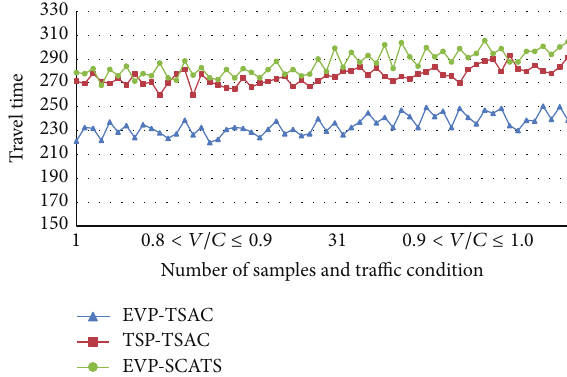
Figure 8: Transit travel time with 0.8 < 𝑉/𝐶 ≤ 1.0 for different traffic signal control